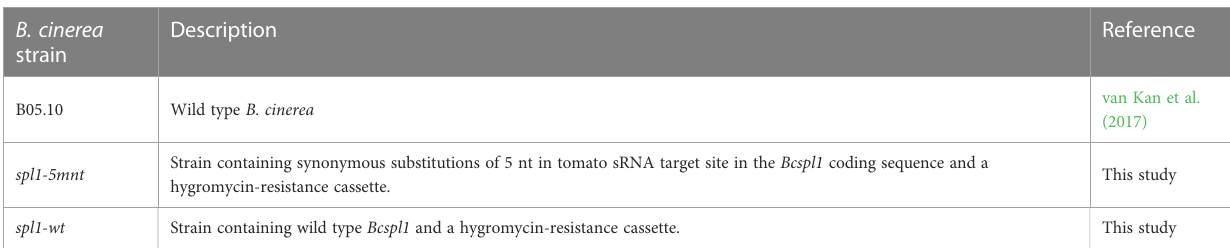
TABLE 1 B. cinerea strains used in this